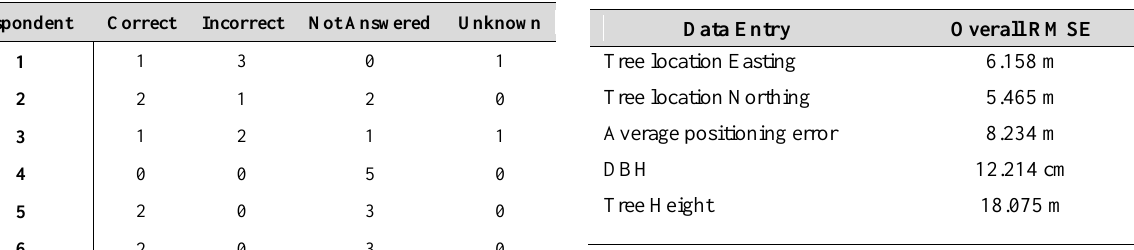
Table 3. The frequencies of ‘not answered’, ‘correct’ and ‘incorrect’, ‘unknown’ answer of tree names in task 2